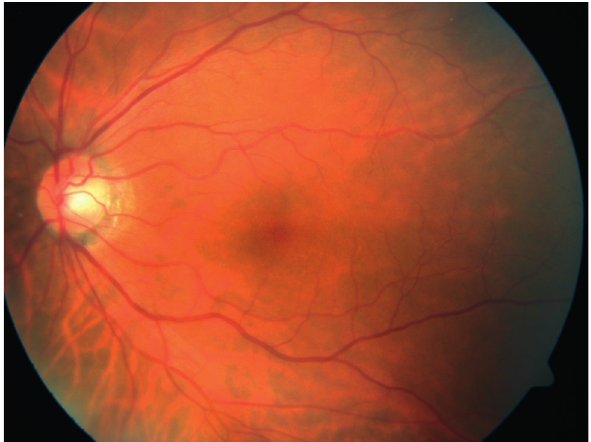
Fig. 3. Improvement of the state - resolution of epiretinal mem- brane.